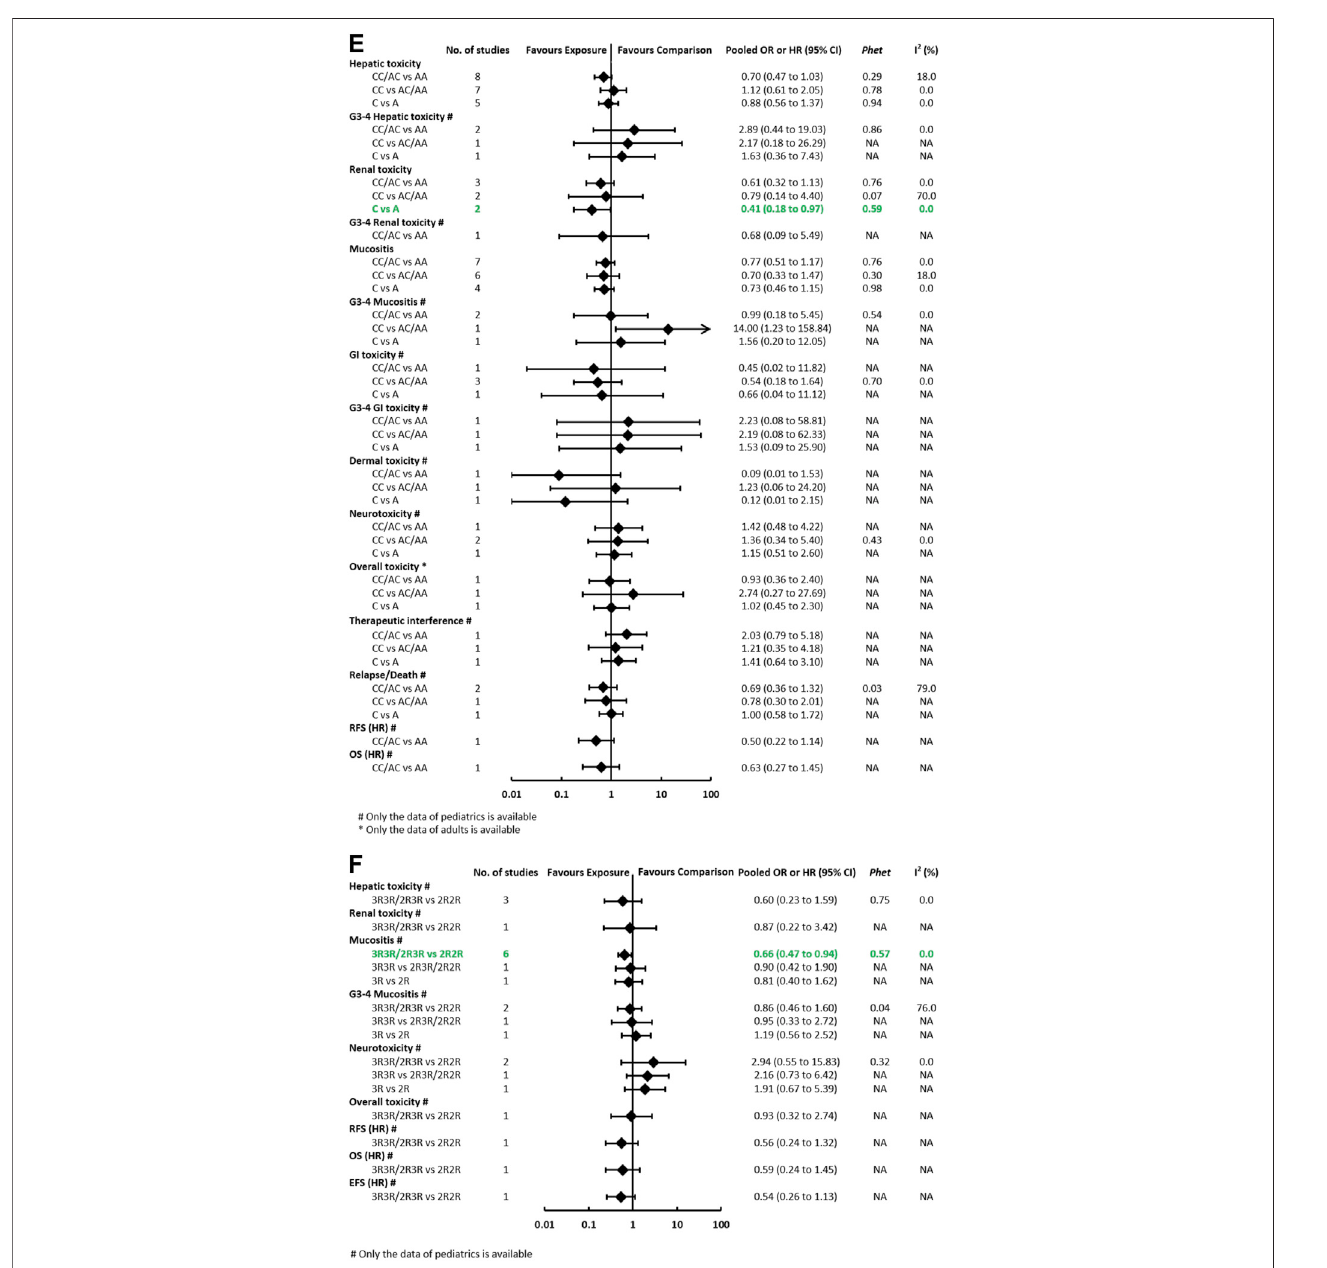
FIGURE 3E-F | (E) Findings of the association between MTHFR (rs1801131) and HDMTX-related outcomes under three genetic models. (F) Findings of the association between TYMS (rs34743033) and HDMTX-related outcomes under three genetic models.